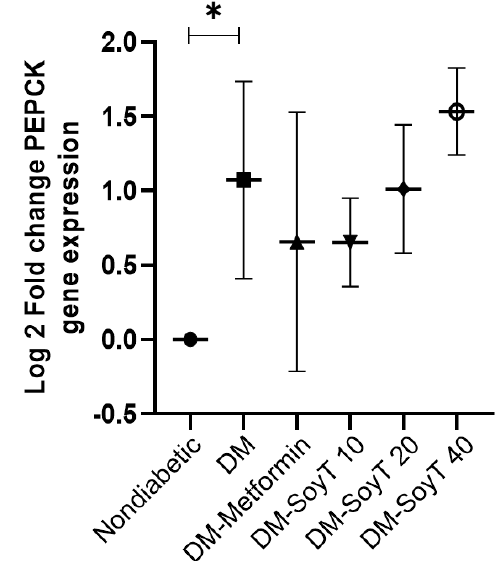
Figure 1. Log 2 fold change in liver RBP4 gene expression. A one-way ANOVA with Dunnett's multiple comparisons post-hoc analysis was used for statistical analysis, with *p<0.05 indicating a significant difference from control (DM).